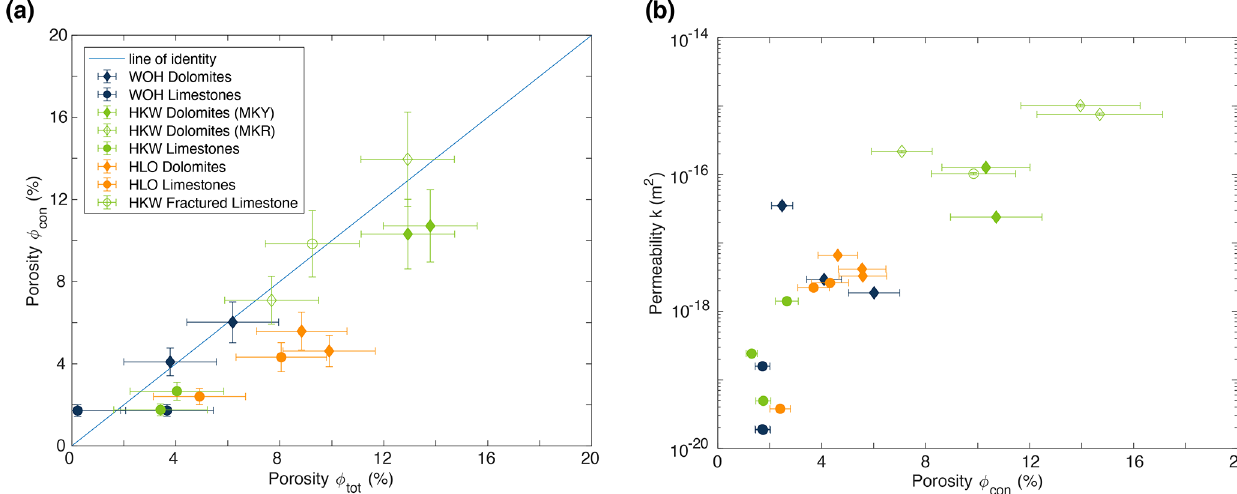
Figure 8. Correlation between (a) connected and total porosity and between (b) permeability and connected porosity. Filling and colouring of markers indicate sample and outcrop, respectively. Measurement uncertainties are indicated by error bars. Where error bars do not exceed marker size, uncertainties appear to be small. The blue line in panel (b) indicates identity, i.e. connected porosity corresponds exactly to total